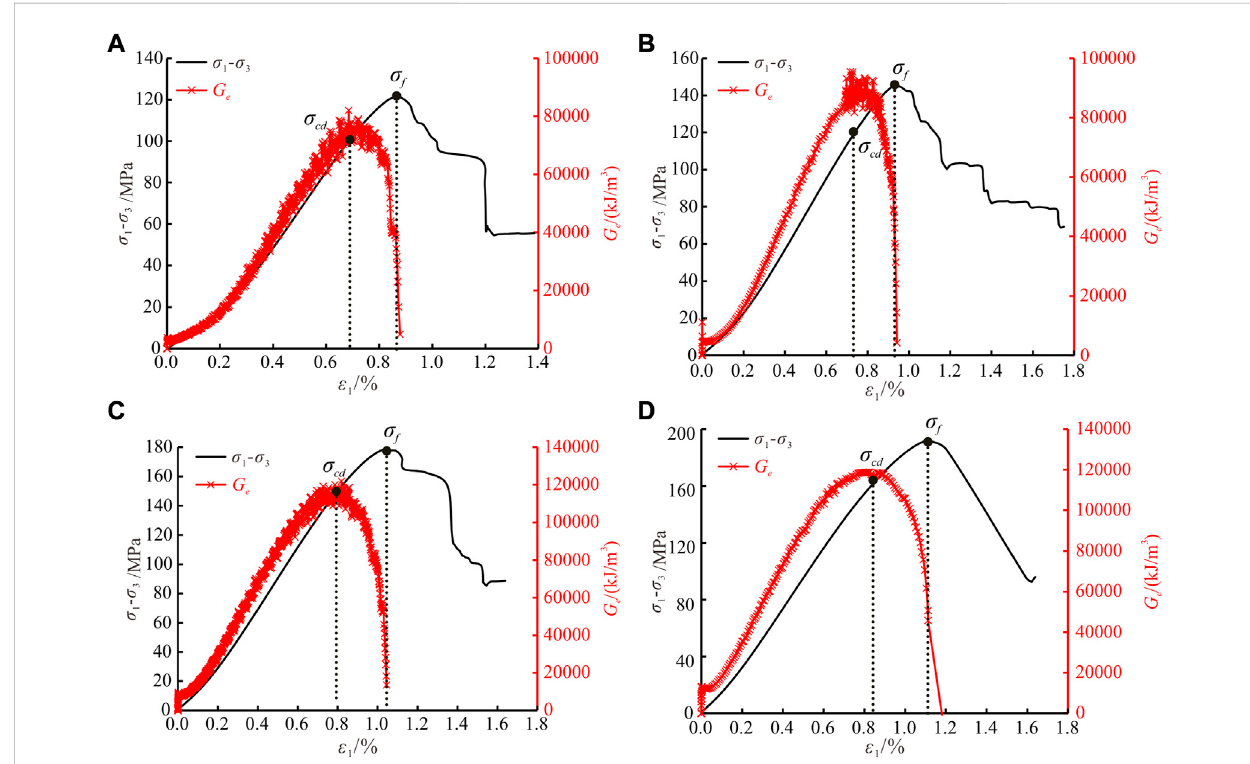
FIGURE 8 The elastic strain energy storage ef fi ciency under CTC. (A) σ 3 = 5 MPa. (B) σ 3 = 10 MPa. (C) σ 3 = 15 MPa. (D) σ 3 = 20